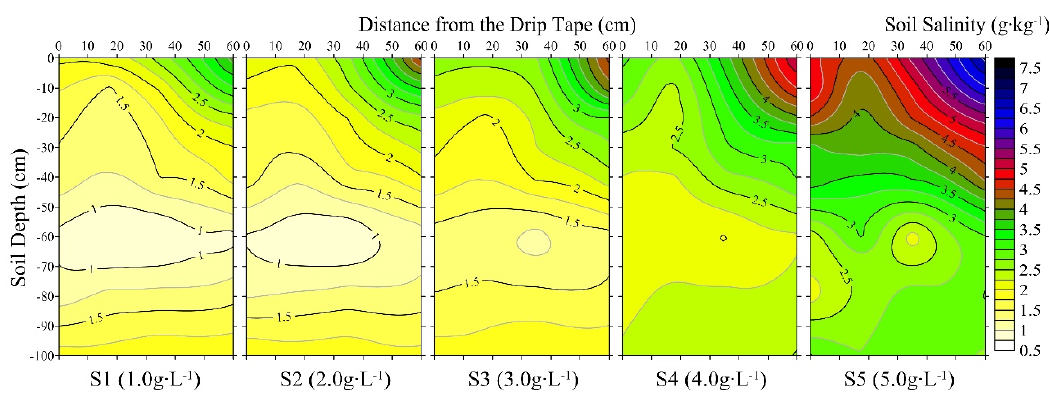
3.6. Effects of Irrigation Water Salinity on Soil Salt Distribution and Accumulation